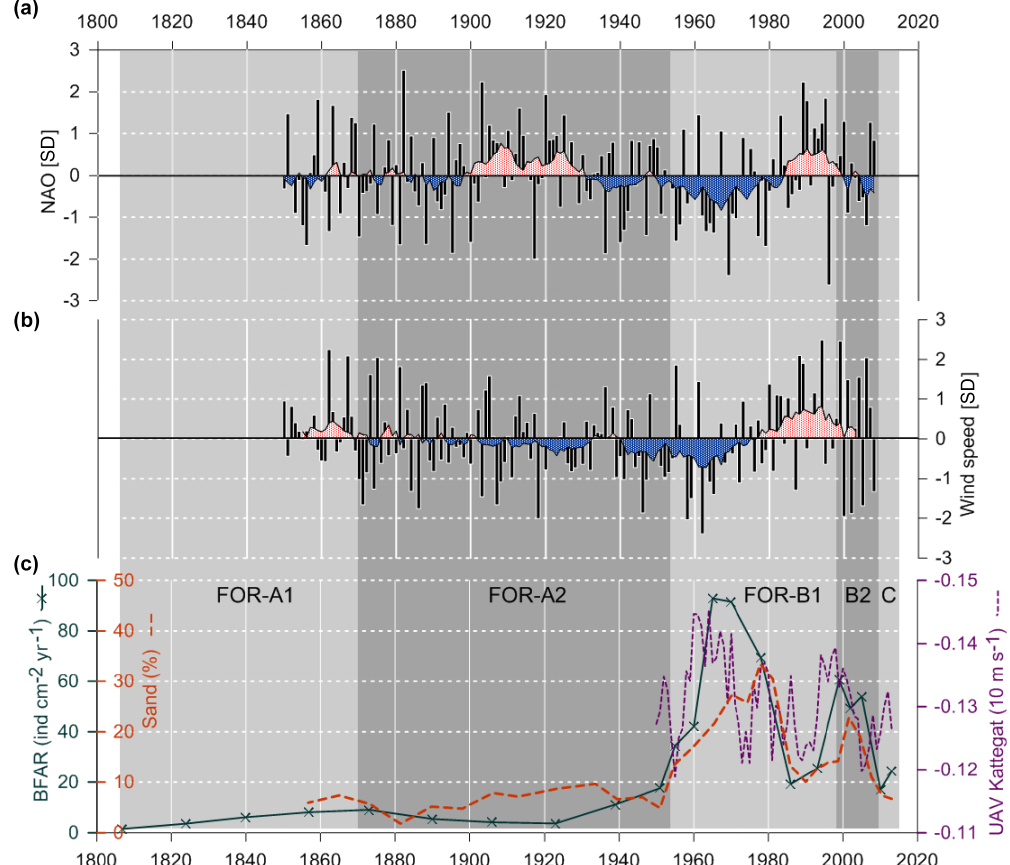
Figure 9. (a) NAO index for boreal winter (December to March), data from Jones et al. (1997). (b) Variations of near-surface (10m) wind conditions (October to March), data from Schenk and Zorita (2012). Both NAO index and wind speed data are normalized on the period 1850–2008 and show running decadal means. (c) BFAR, percentage of sand fraction and west–east flow (UAV) in the Kattegat. Foraminiferal zones